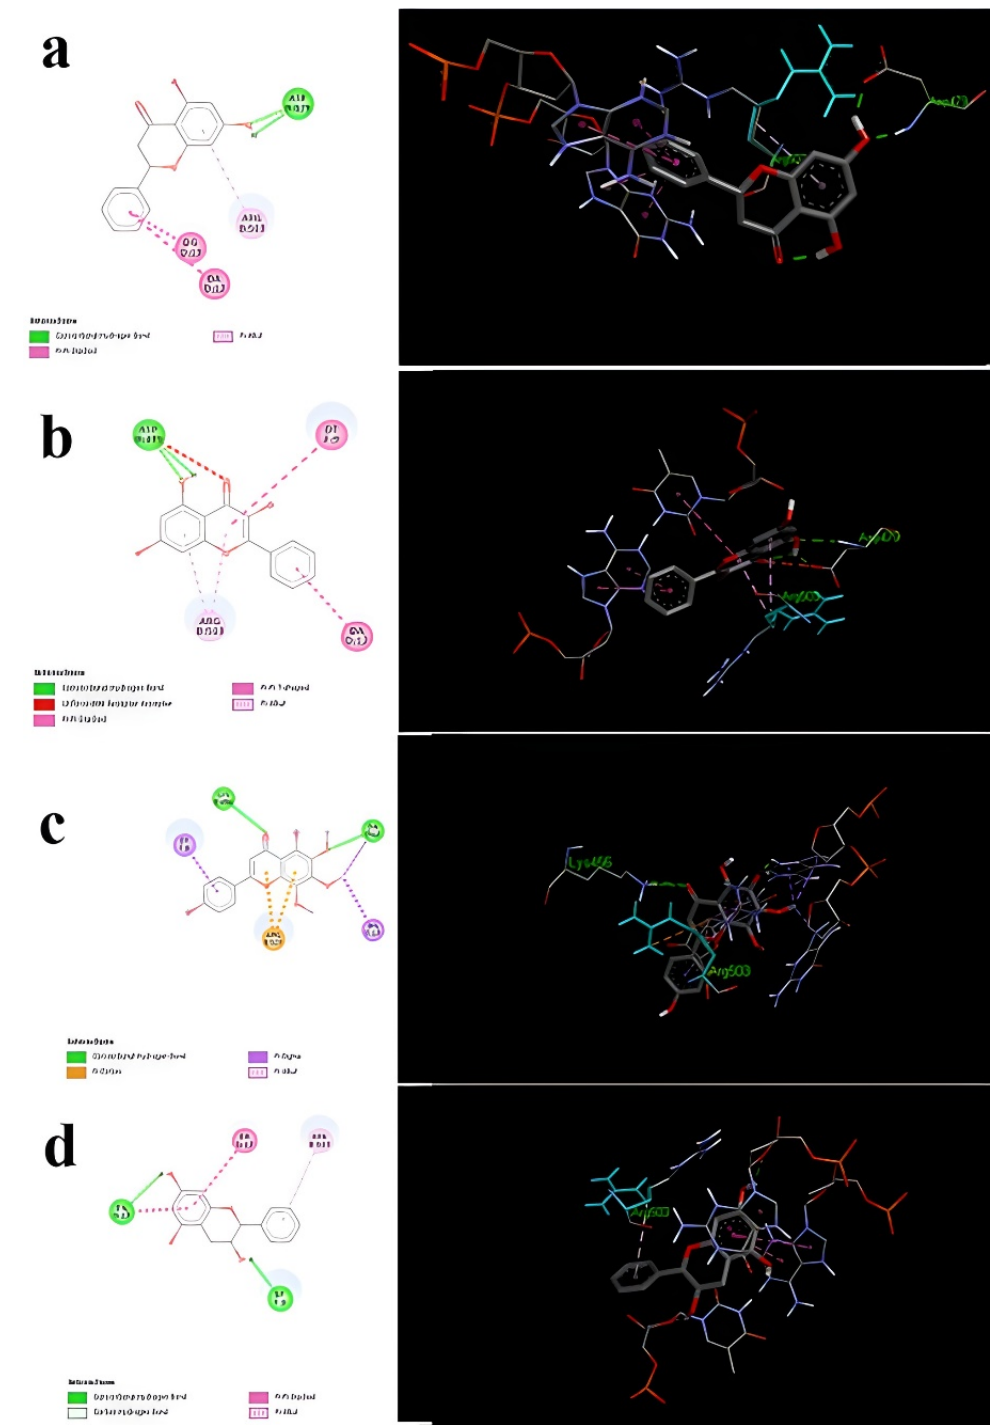
Figure 6. ( a ). Interaction of galangin with the active site of topoisomerase II β (TOP II β ) in ( a ) 2D and ( b ) 3D; ( b ). Interaction of xanthomicrol with the active site of topoisomerase II β (TOP II β ) in ( a ) 2D and ( b ) 3D; ( c ). Interaction of pinocembrin with the active site of topoisomerase II β (TOP II β ) in ( a ) 2D and ( b ) 3D; ( d ). Interaction of pinobanksin with the active site of topoisomerase II β (TOP II β ) in ( b ) 2D and ( c ) 3D.